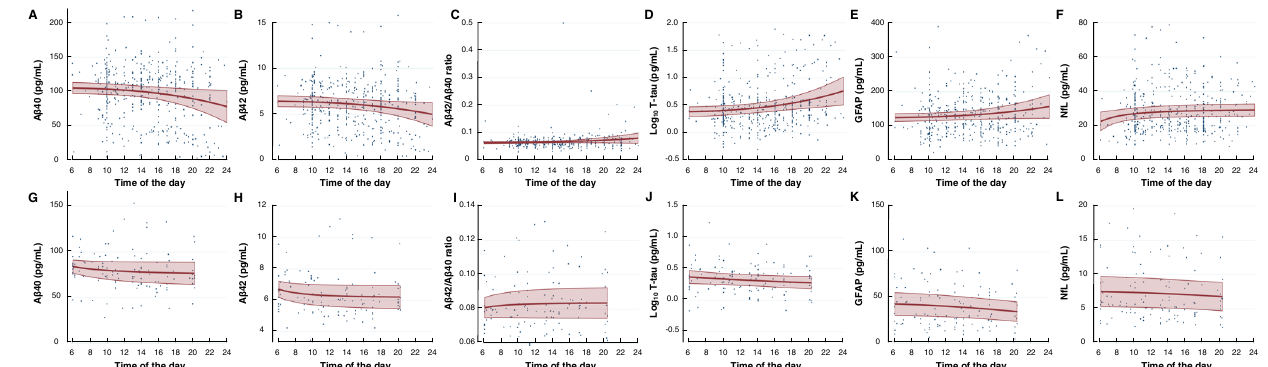
Fig.6|DaytimevariationinplasmabiomarkerconcentrationswithintheiNPH ( n =54) and IIH ( n =13) cohorts. Repeated measurements of biomarker con- centrations in plasma of iNPH showed different pro fi les depending on the bio- marker examined: A A β 40 ( P =0.039), B A β 42 ( P =0.055), C A β 42/ A β 40 ratio ( P =0.134), D T-tau( P <0.001), E GFAP( P =0.072),and F NfL( P =0.030;regression analysis). The pro fi le of daytime variation for IIH subjects differed: G A β 40